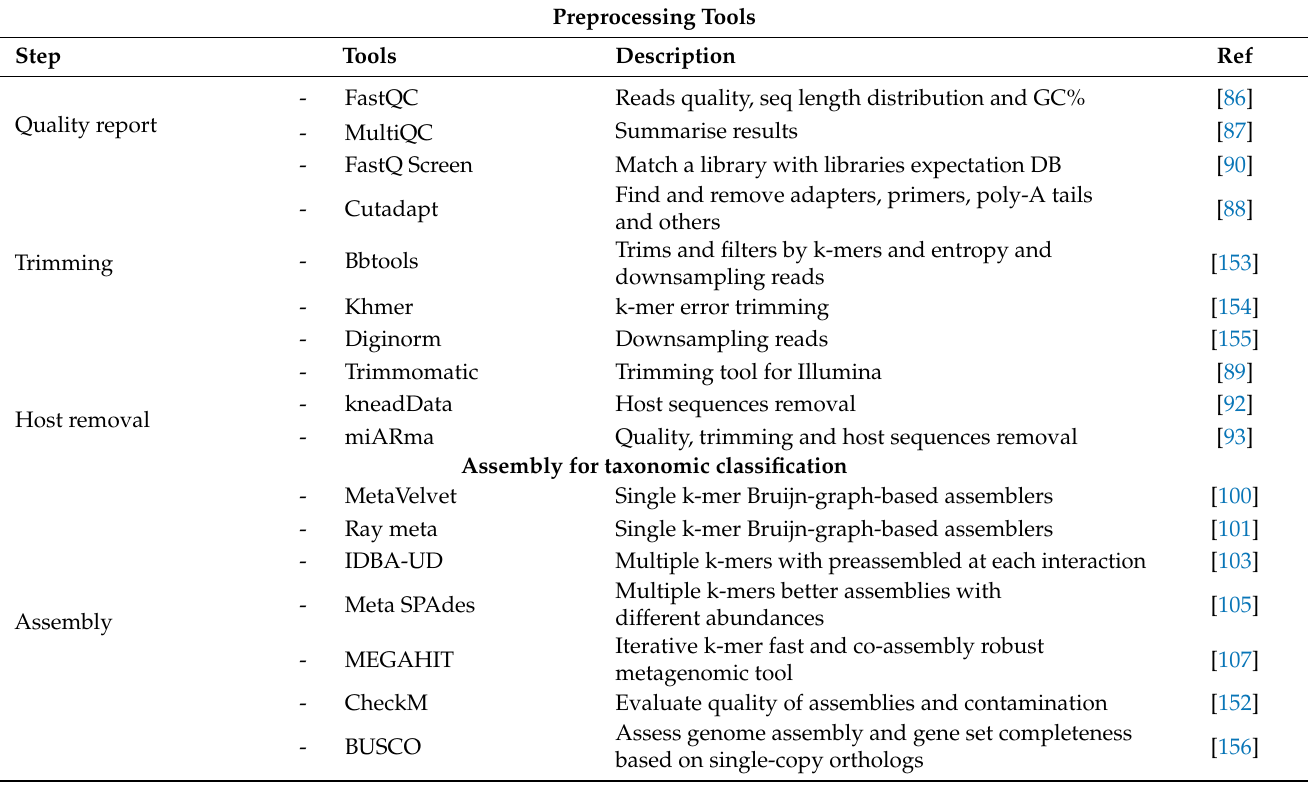
Table 1. Bioinformatic tools for metagenome and metatranscriptome analysis. Preprocessing